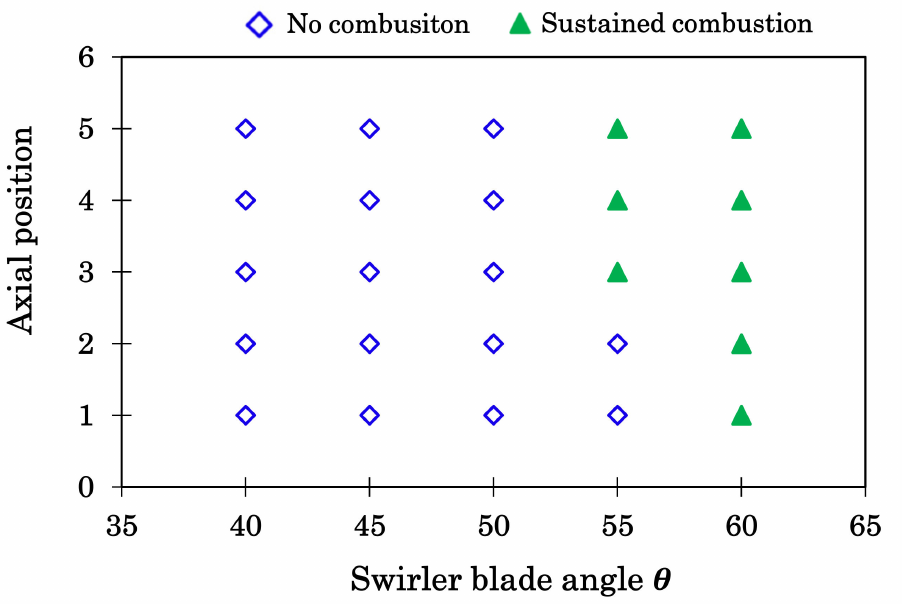
Figure 21. Combustion stabilisation analysis.